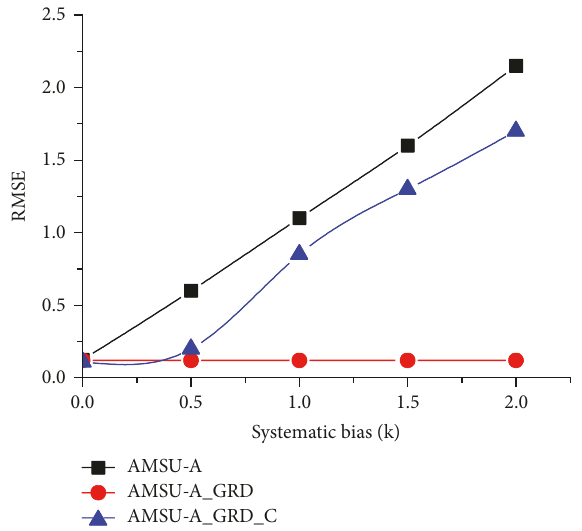
Figure 1: Comparison of RMSE with different systematic bias.